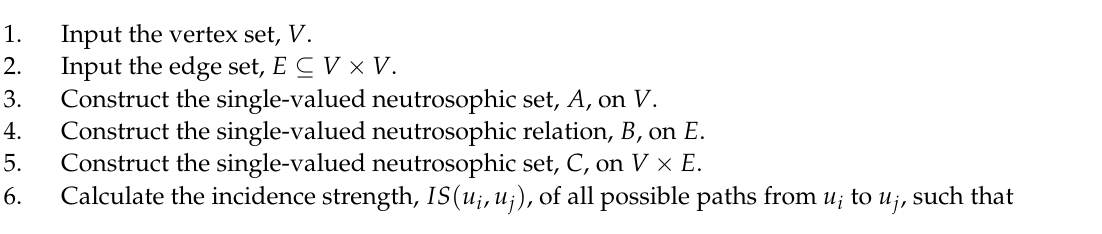
Algorithm 1 Method of Finding Neutrosophic Incidence